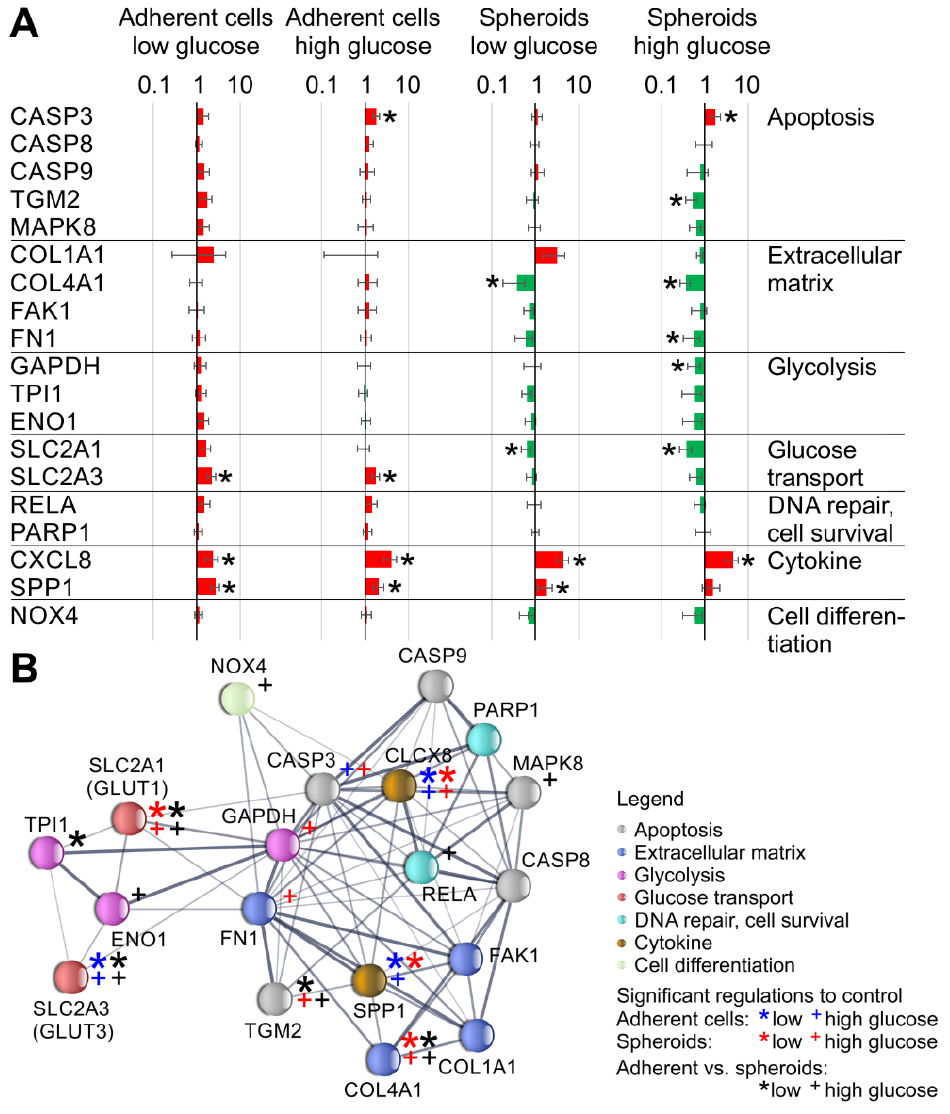
Figure 12. Overview of gene expression changes in the 19 genes quantified through qPCR. ( A ) Gene expression ratios. Significant regulations ( p < 0.05) are indicated with an asterisk; upregulations or downregulations compared to the 1 g control are indicated in red and green, respectively. ( B ) EMBL STRING protein–protein interaction of the 19 genes examined. Medium confidence interactions (0.4) with the colour-coded area of protein action are